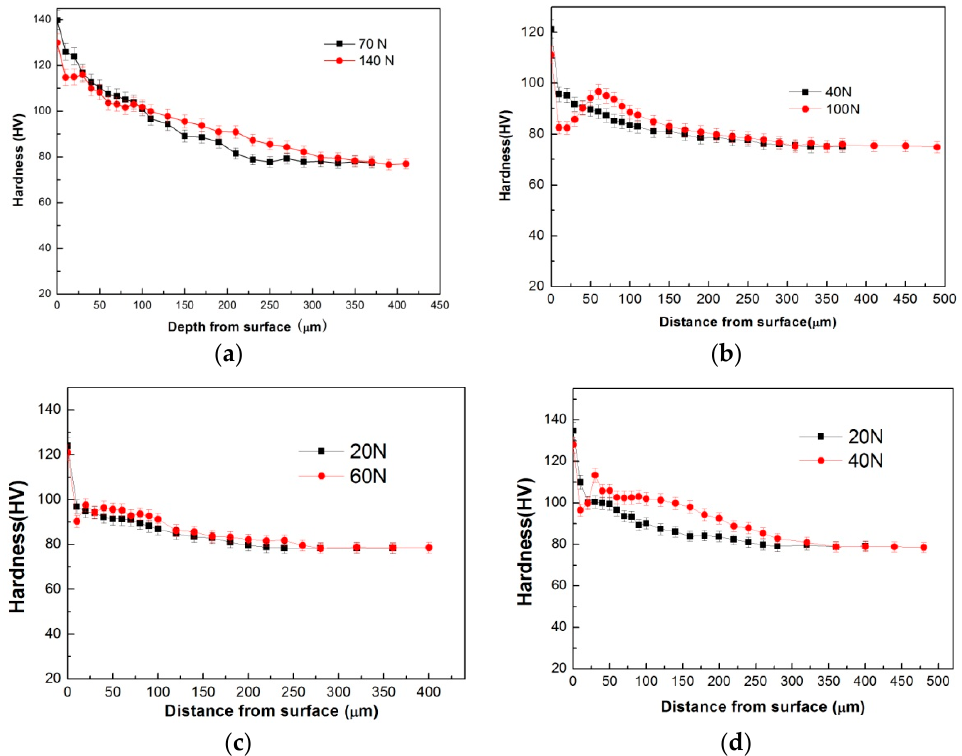
Figure 9. Hardness vs. depth from surface for Mg97Zn1Y2 alloy pins worn at 100 °C and 200 °C under different sliding speeds: ( a ) 100 °C, ( b ) 200 °C, 0.8m/s, ( c ) 100 °C, ( d ) 200 °C, 3.0 m/s.